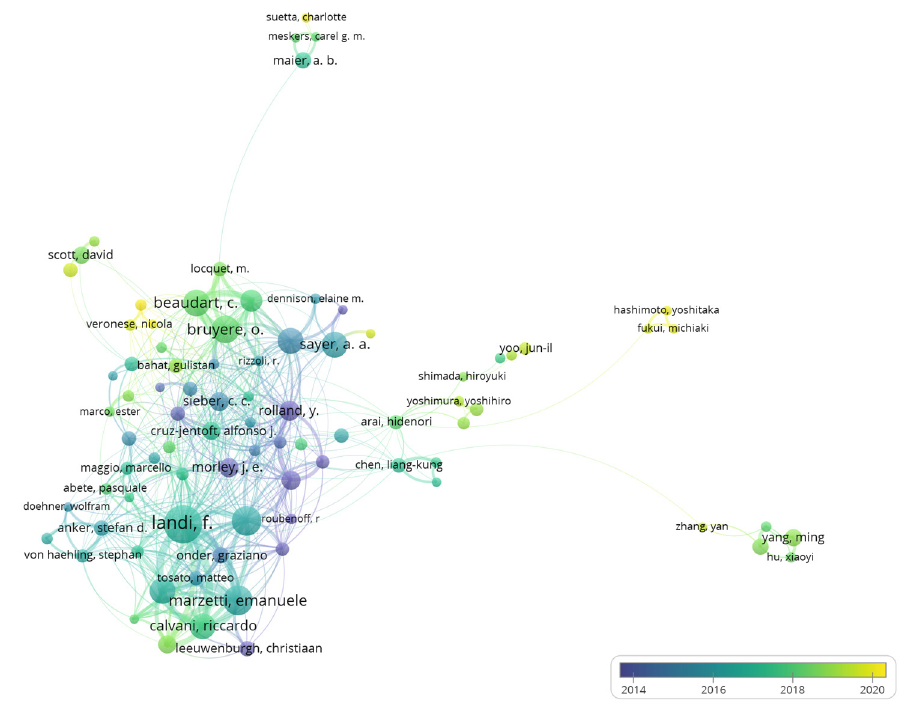
Figure 4. Coauthorship of 85 authors with at least 10 publications in sarcopenia.